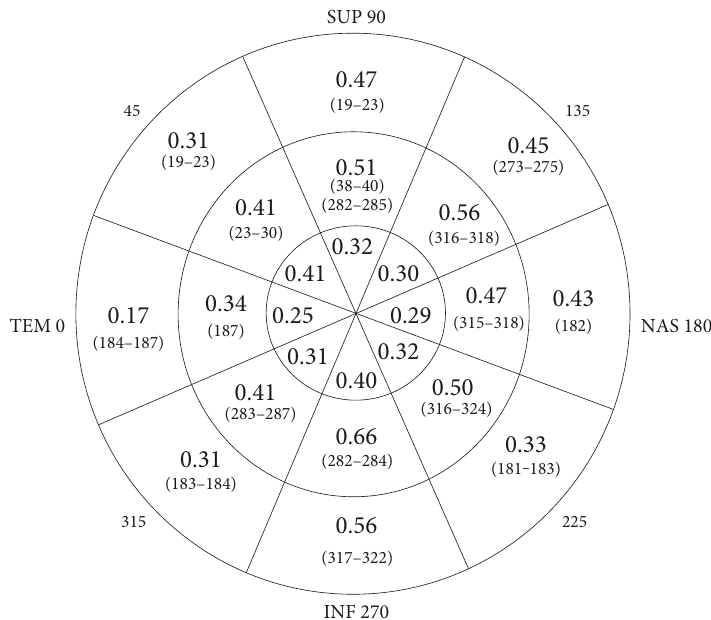
Figure 5: Best correlation coe ffi cients obtained in each sector of the optic nerve head and thicknesses speci fi ed by its angular position (degrees) of the circle of fi ber thickness where they were obtained (below the correlations, in brackets).